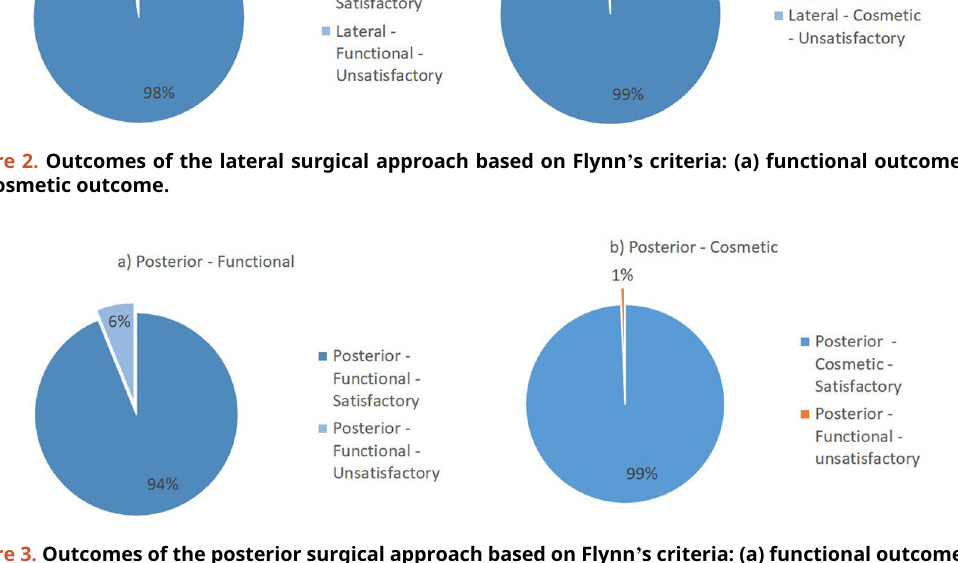
Figure 3. Outcomes of the posterior surgical approach based on Flynn ’ s criteria: (a) functional outcome and (b) cosmetic outcome.